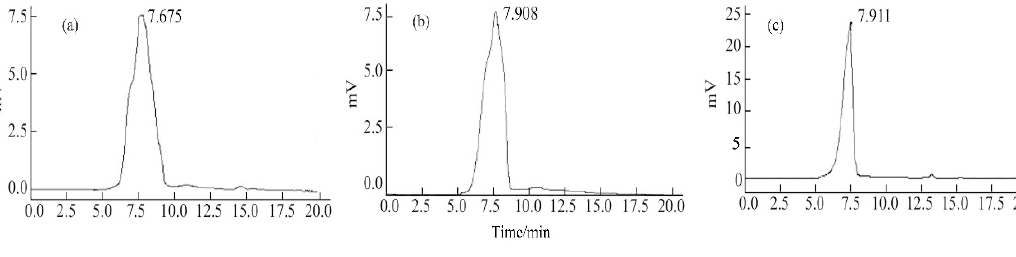
Figure 3. The HPGPC profiles of EPS1a ( a ), EPS2a ( b ), and EPS3a ( c ) determined by a HPLC System. The mobile phase was ultrapure water at a flow rate of 0.8 mL/min. The temperature of the chromatographic column (Shodex OHpak SB-804 HQ) was 30 °C.